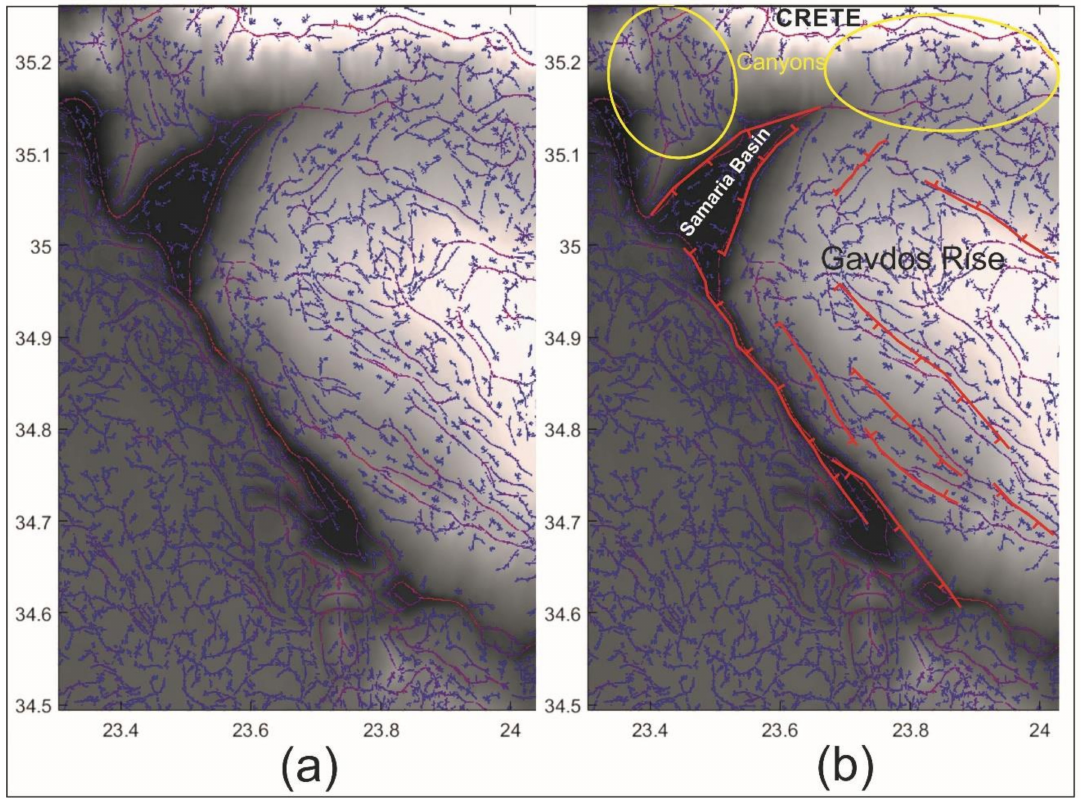
Figure 6. An example showing the comparison of the ( a ) automatically detected linear and curvilinear elements from the western part of Gavdos Rise in South Crete with ( b) geological faults (thick red lines) from previous research [43–45] and references therein. The yellow ellipsis indicates areas of canyons